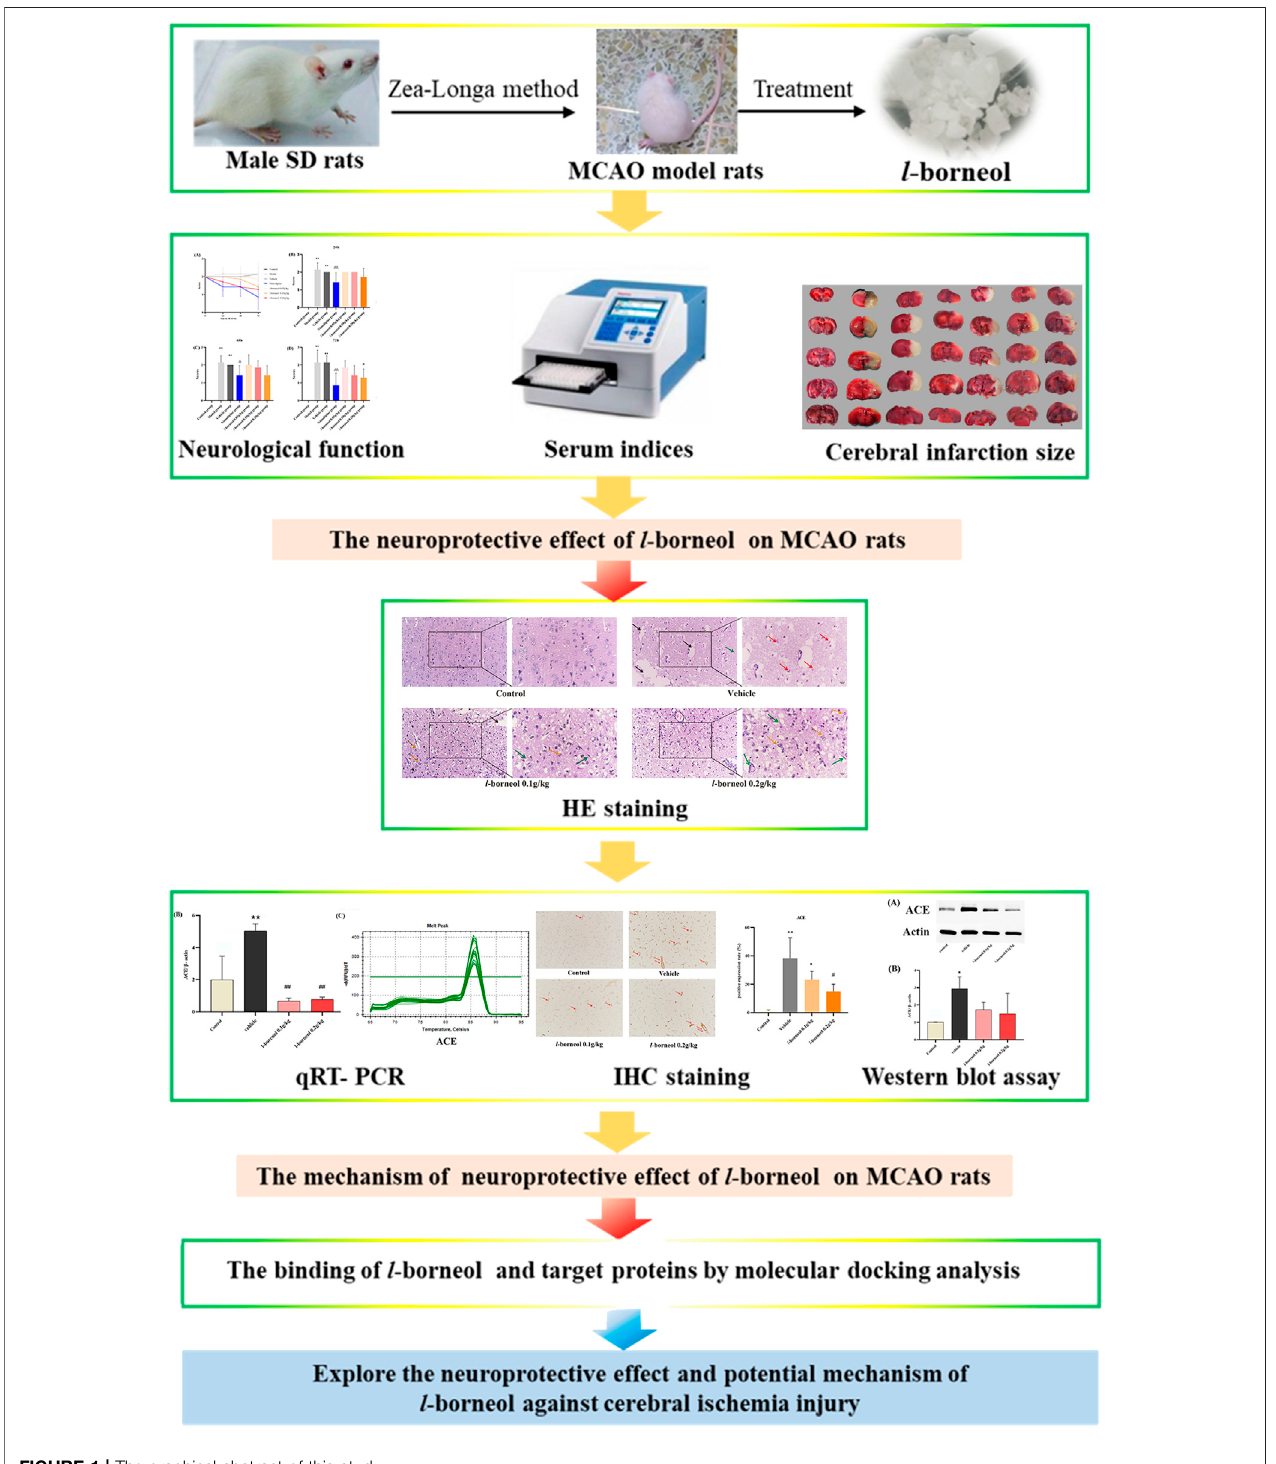
FIGURE 1 | The graphical abstract of this